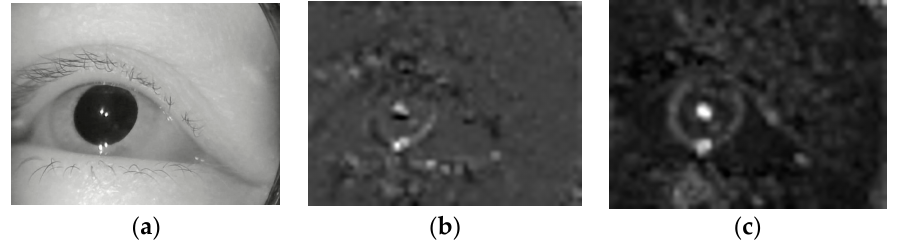
Figure 7. Comparison of feature maps between the general feature output and the attention mech- anism output. ( a ) Original image. ( b ) The general feature output. ( c ) The attention mechanism out- put.